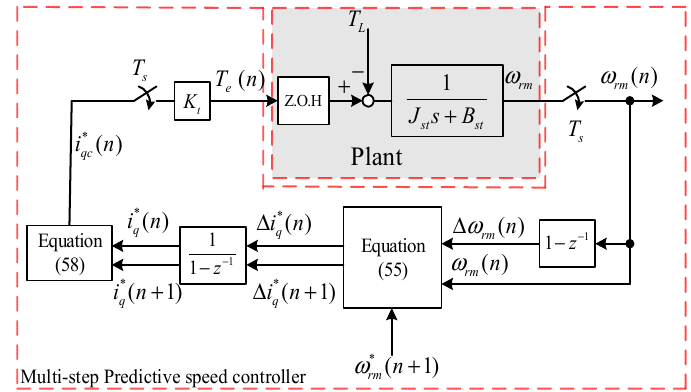
Figure 7. Multi-step predictive speed controller.